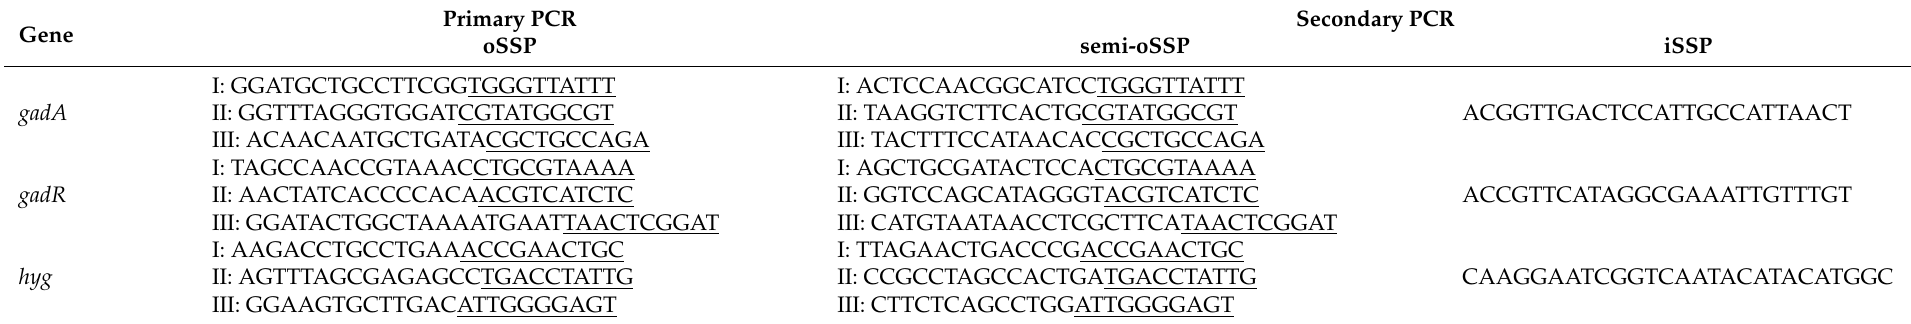
Table 1. Primers used in this